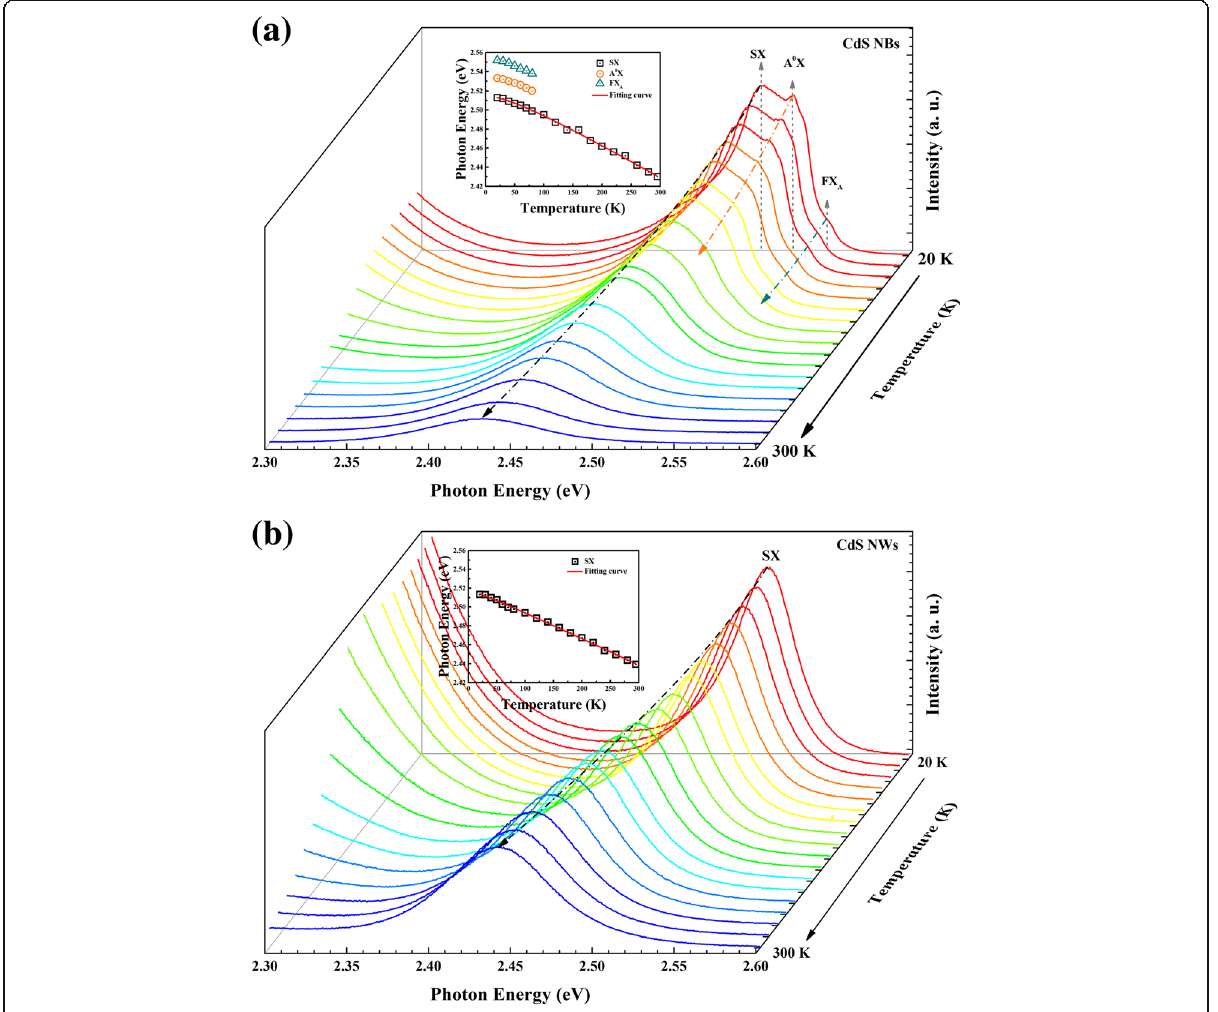
Fig. 2 a Temperature-dependent PL spectra of CdS NBs in the range from 20 K to 295 K, the inset is plots of FX A , A 0 X, and SX peaks as a function of temperature. b Temperature-dependent PL spectra of CdS NWs in the range from 20 K to 295 K, the inset is SX peak redshift with the temperature, and the solid red curve of the SX is corresponding to the fit result based on Varshni